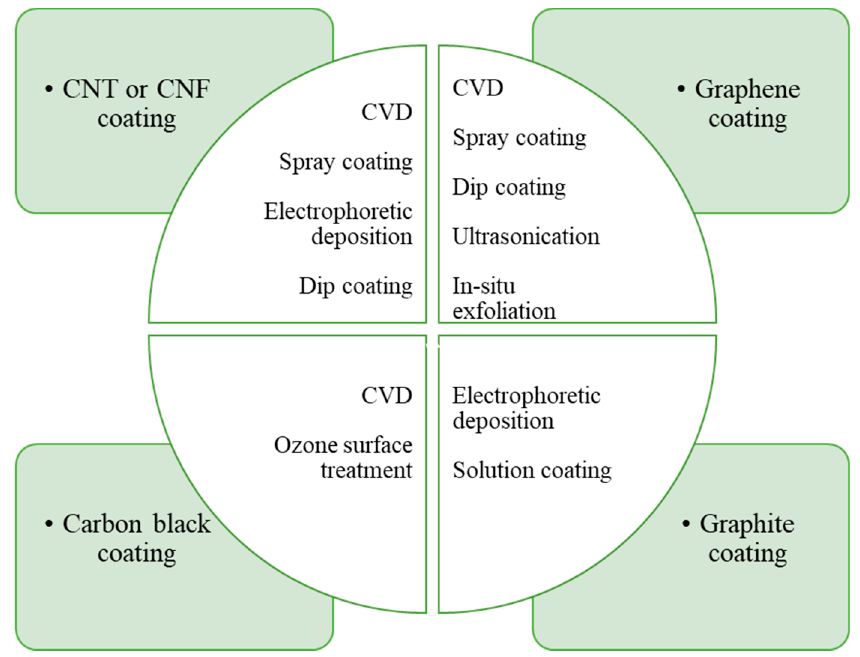
Figure 8. Carbon materials and techniques used for CF coating to fabricate polymer composites.